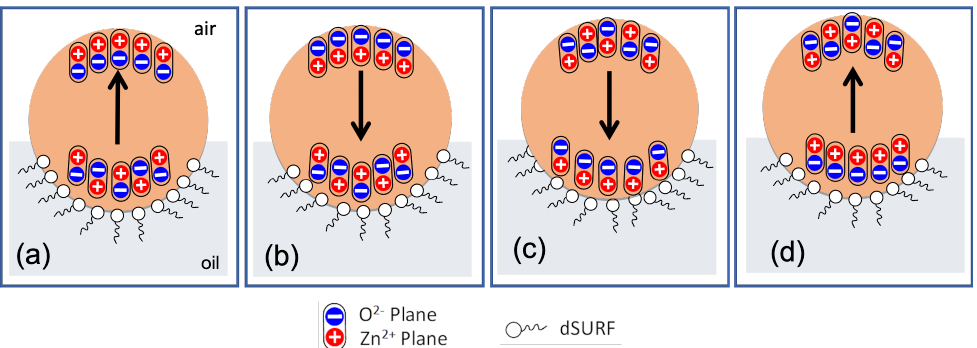
Figure 10. Schematic illustration of different possible asymmetric orientations of ZnO nanoparticles at droplet/air and droplet/oil interfaces (leading to dipolar microdroplets); ( a , b ): parallel orientation of ZnO NPs at the droplet/air interface and an anti-parallel orientation at the droplet/oil interface; ( c , d ): parallel orientation of ZnO NP dipoles at the droplet/oil interface and an anti-parallel orientation at the droplet/air